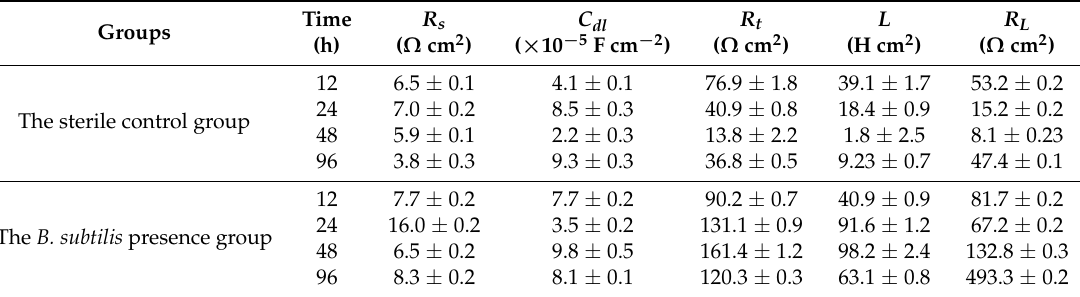
Figure 5. EIS with immersion time of AZ31B magnesium alloy coupons in the control group and the B. subtilis presence group. ( A – D ): Nyquist diagrams, ( A’ – D’ ): the Bode modulus diagrams and Bode phase angle diagrams. Table 4. EIS parameters with immersion time of AZ31B magnesium alloy coupons in the control group and the B. subtilis presence group. R s represents the solution resistance, C dl represents double layer capacitance, R t represents charge-transfer resistance, L represents equivalent inductance, R L represents equivalent resistance.